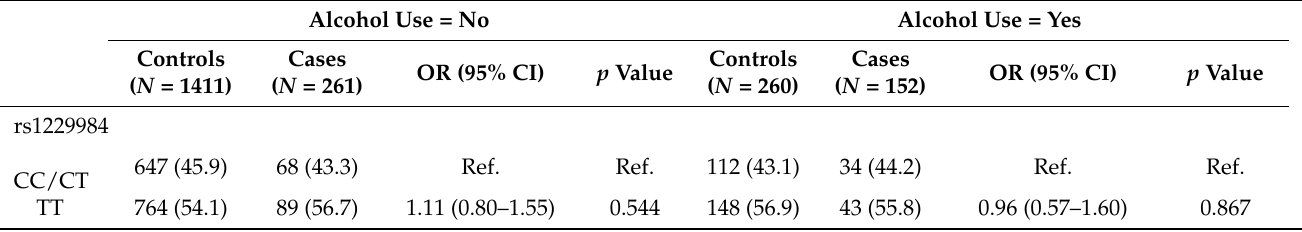
Table 4. Associations between ALDH genes and nasopharyngeal carcinoma susceptibility after stratification for alcohol use. Alcohol Use = No Alcohol Use = Yes